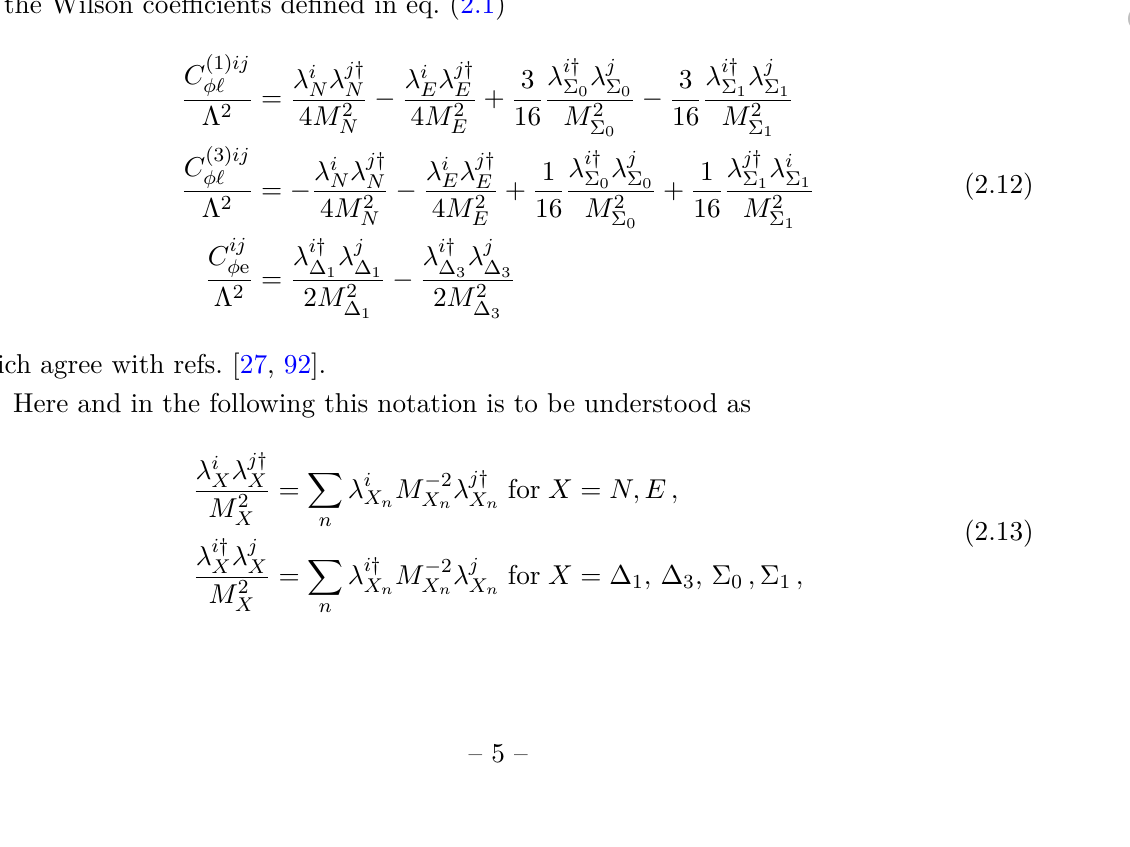
Figure 1 . Feynman diagrams giving rise to the operator Q (1) ij any of the six VLLs. Note that the first diagram does not give a contribution for N and E